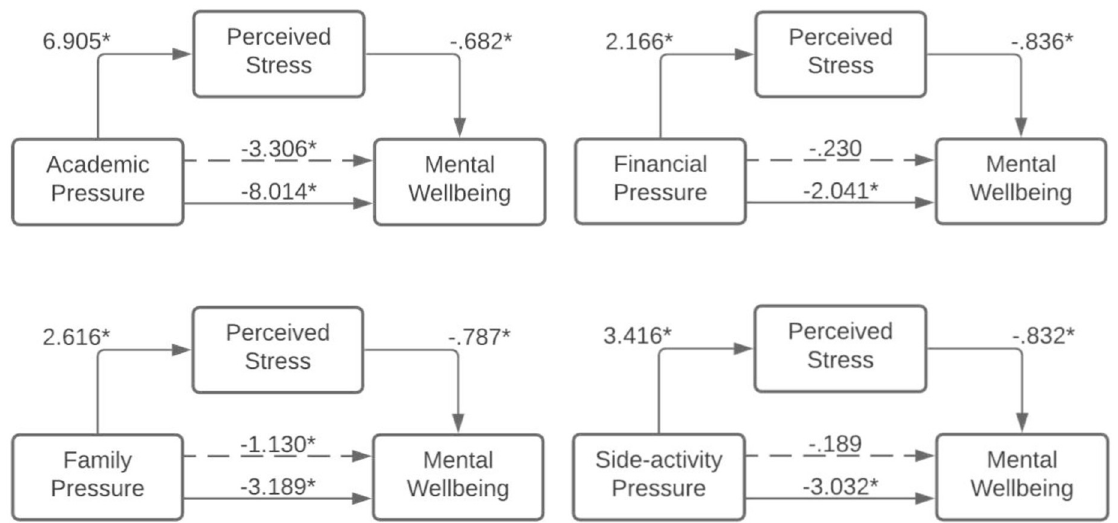
Fig 2. Mediation models of perceived stress between underlying stressors and mental wellbeing showing the total effect (solid line, c) and direct effect after mediation (broken line c’). � p is significant at the < 0.01 level.